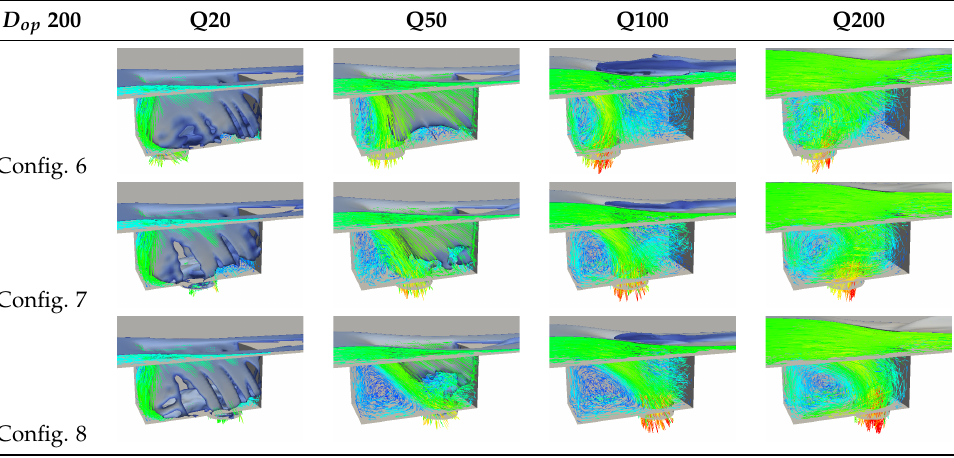
Table 7. Velocity field and free-surface configuration at steady conditions—Configurations 6 to 8 (Q20, Q50, Q100, and